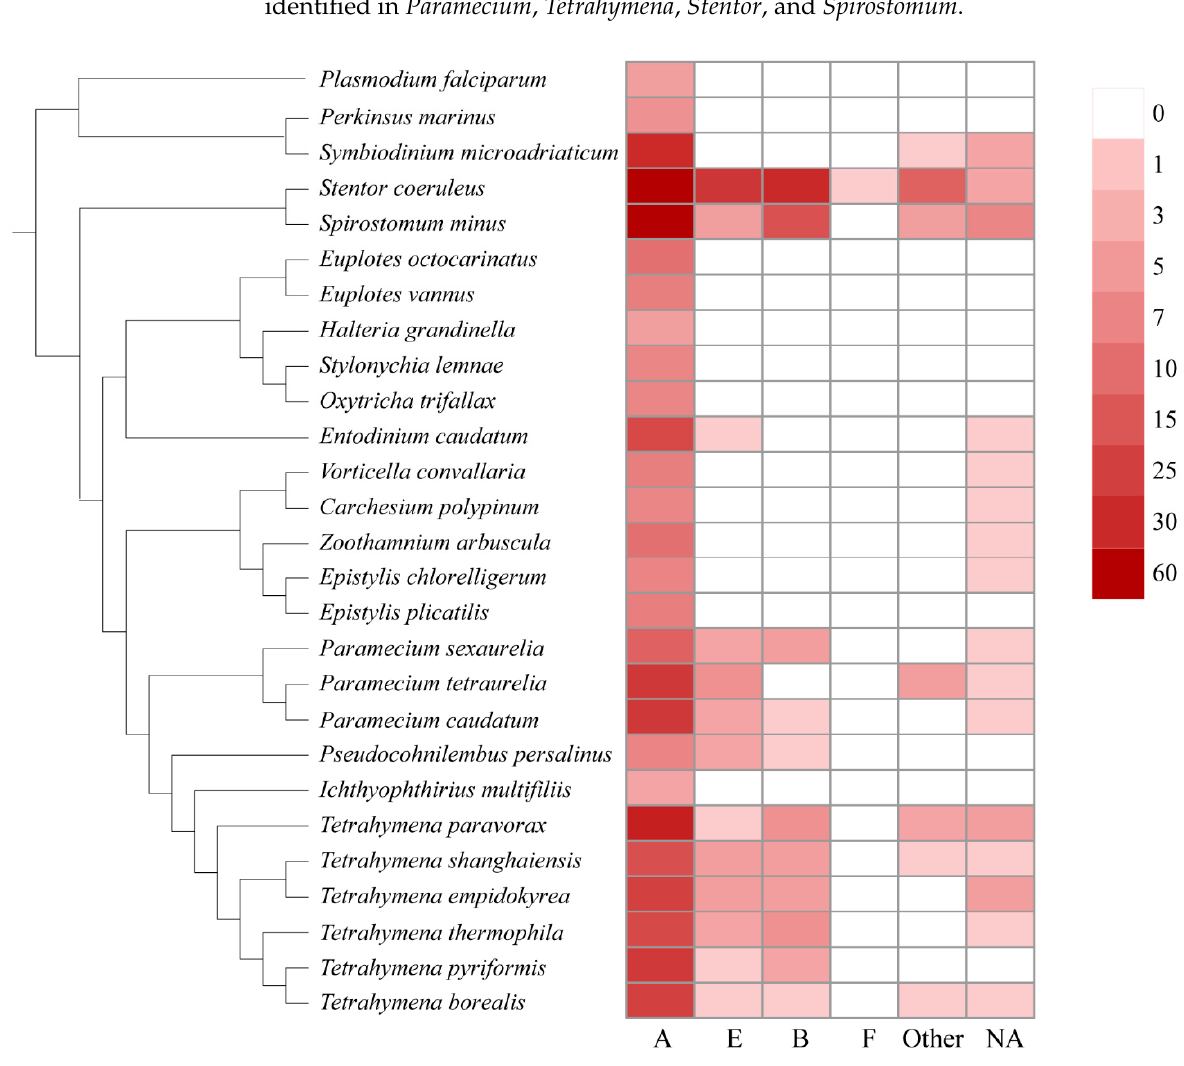
Figure 2. Distribution of different GPCR families in ciliates.